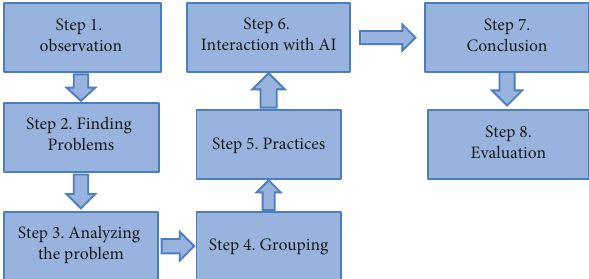
Figure 9: Eight syntaxes of AI and improving CT to